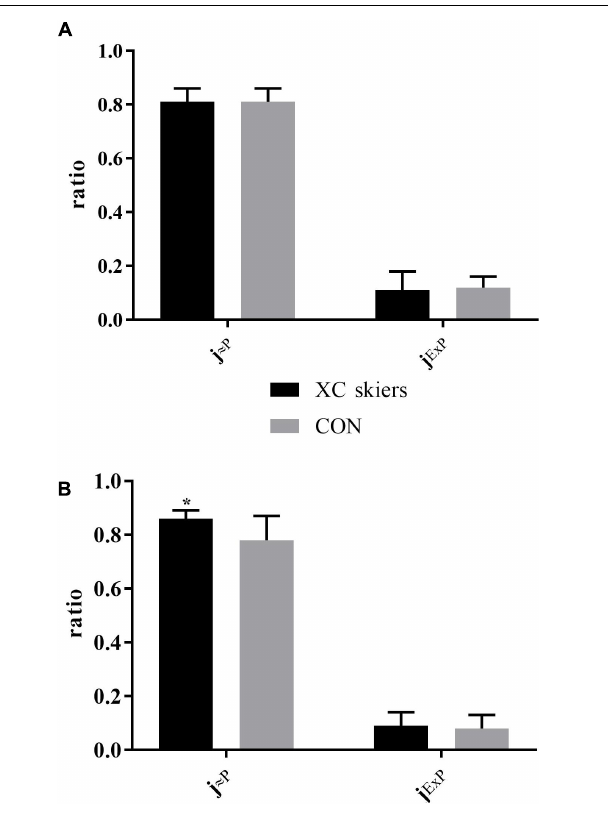
FIGURE 3 | Differences in respiratory control ratios in M. triceps brachii and M. vastus lateralis between elite cross-country skiers (XC skiers) and physically active controls (CON). (A) M. vastus lateralis and (B) M. triceps brachii. Mitochondrial quality noted as ratio between 0 and 1 for oxidative phosphorylation capacity efficiency (j ≈ P ) and excess electron transfer system-phosphorylation capacity factor (j ExP ). Data are displayed as means ± SD. ∗ Significant difference between groups ( P <